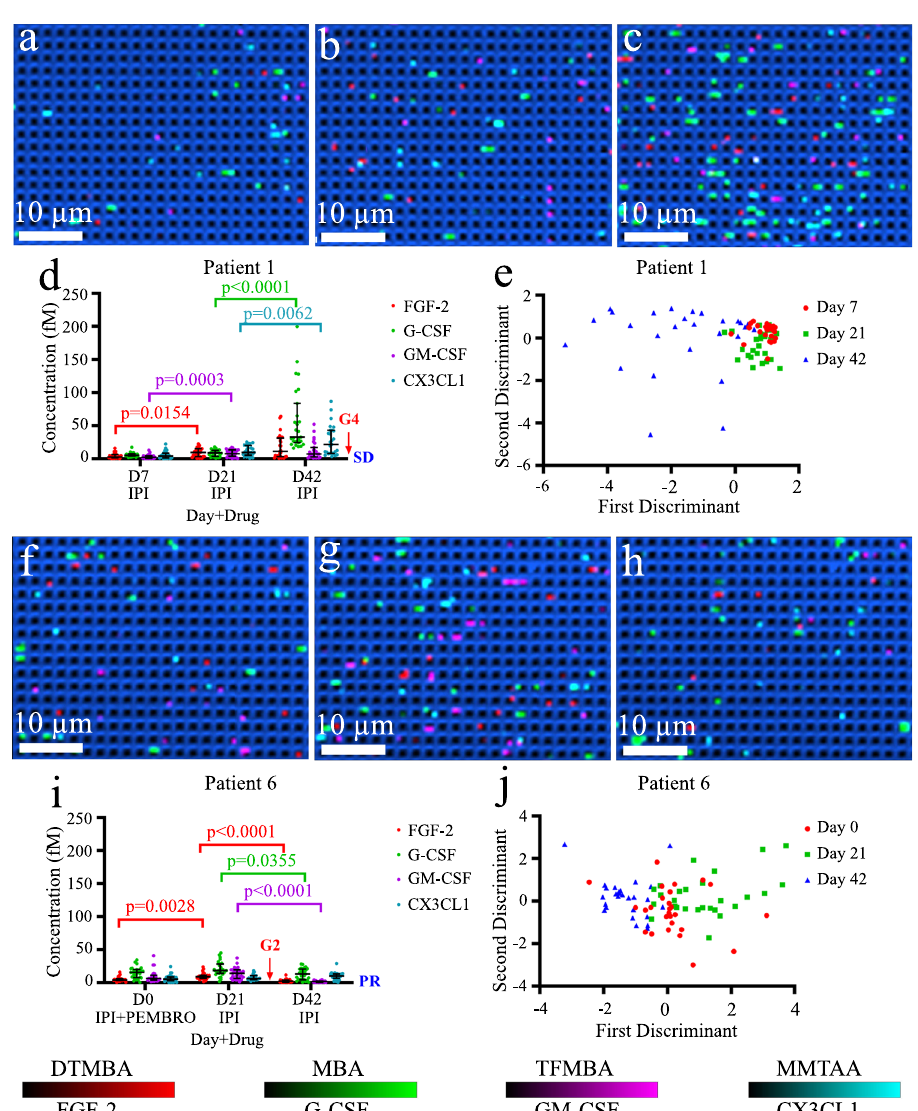
Fig. 7 Digital nanopillar SERS assay for monitoring melanoma patients during immune checkpoint therapy. For Patient 1 who developed severe irAEs, SERS images for cytokine detection on a day 7, b day 21, c day 42, d cytokine concentration graph for fi broblast growth factor 2 (FGF-2), granulocyte colony-stimulating factor (G-CSF), granulocyte-macrophage colony-stimulating factor (GM-CSF), and fractalkine (CX3CL1). The two shorter horizontal lines denote the interquartile ranges (25th and 75th percentile) and the longer horizontal lines in between denote the median (50th percentile), and e LDA analysis, respectively. For Patient 6 who developed mild irAEs, SERS images for cytokine detection on f day 0, g day 21, h day 42, i four cytokine concentration graph, the two shorter horizontal lines denote the interquartile ranges (25th and 75th percentile) and the longer horizontal lines in between denote the median (50th percentile), and j LDA analysis, respectively. IPI ipilimumab, PEMBRO pembrolizumab; G3 grade 3, G2 grade 2; SD stable disease, PR partial response. For Patient 1, the median (interquartile range) of active pillars per scanning image of FGF-2, G-CSF, GM-CSF, CX3CL1 on day 7: 14